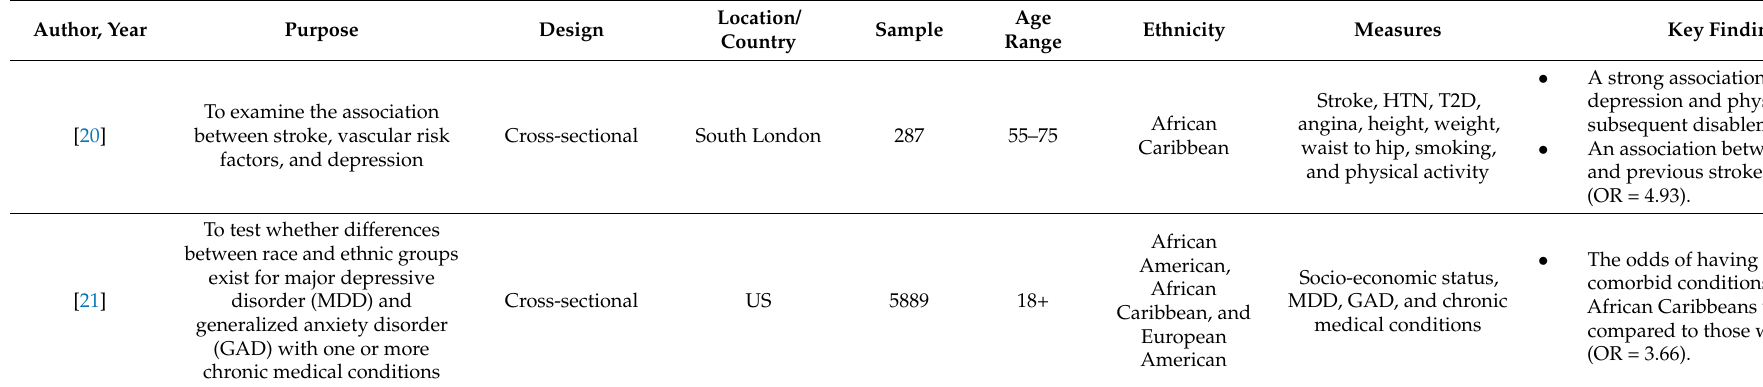
Table 1. Study Characteristics and Key